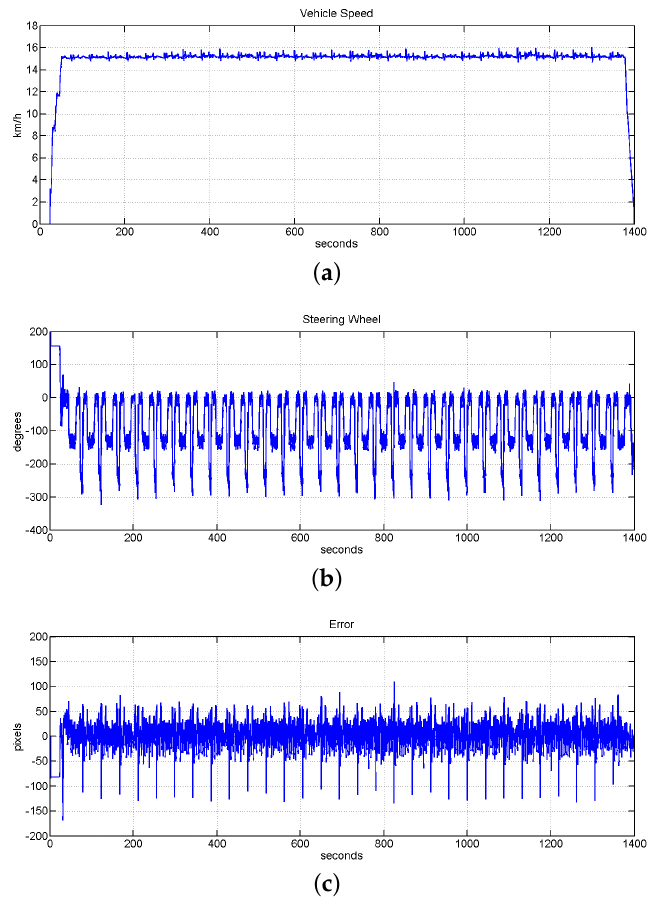
Figure 22. Evolution of the system to check the robustness of the system for a long distance with a reduced speed value. ( a ) Vehicle speed evolution; ( b ) evolution of the steering wheel; ( c ) error measured (in pixels), the value of RMSE for this test is 3.6874